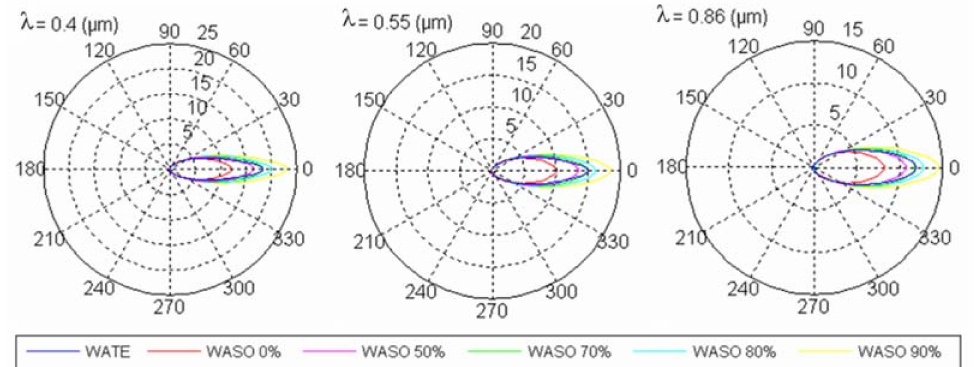
Figure 4. Comparison between phase function (PH) of water-soluble aerosol in 6S (WATE) and OPAC